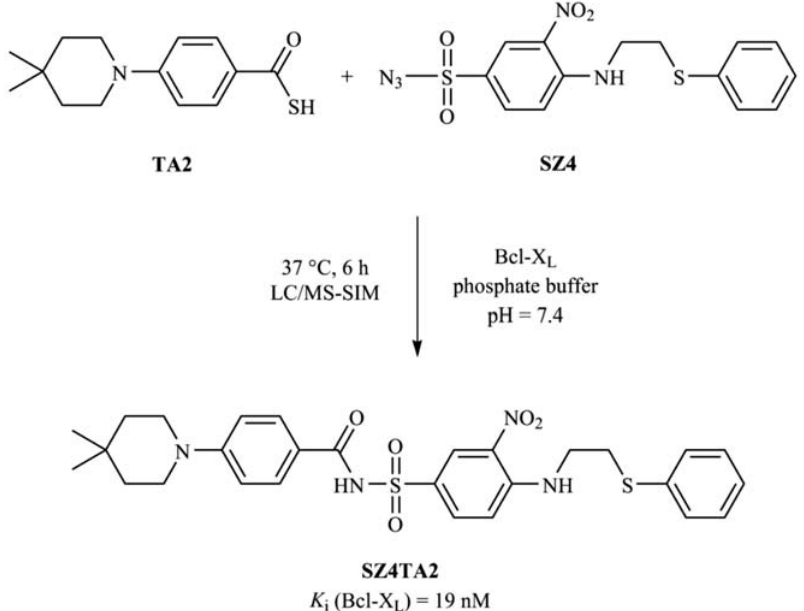
Figure 9. PPIM identification via sulfo-click RAS approach.